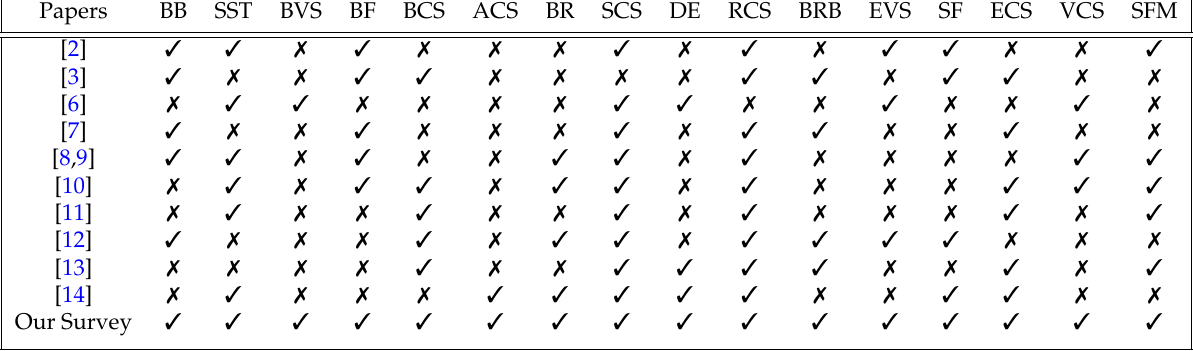
Table 3. Summary of some generic state of art surveys